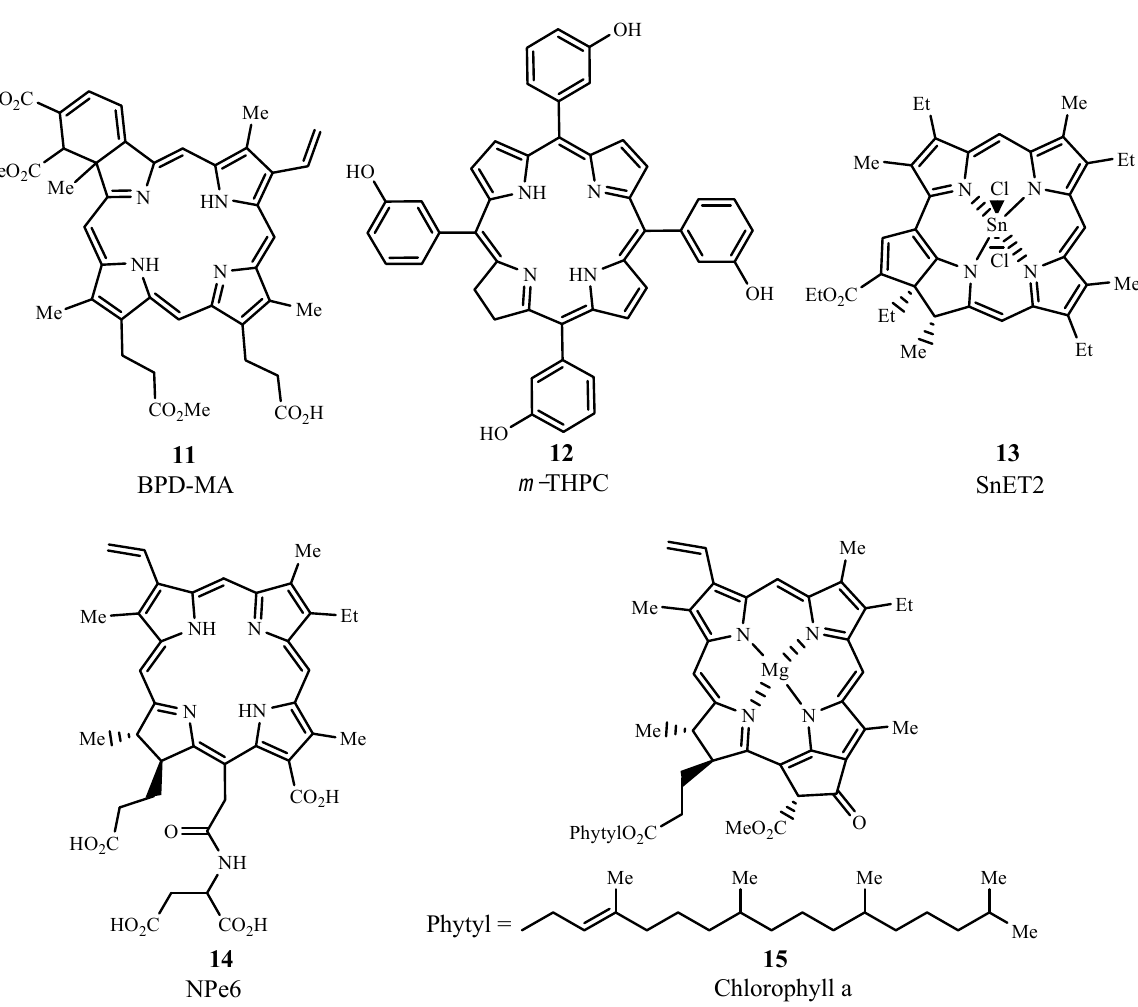
Figure 10. Examples of chlorins evaluated for PDT